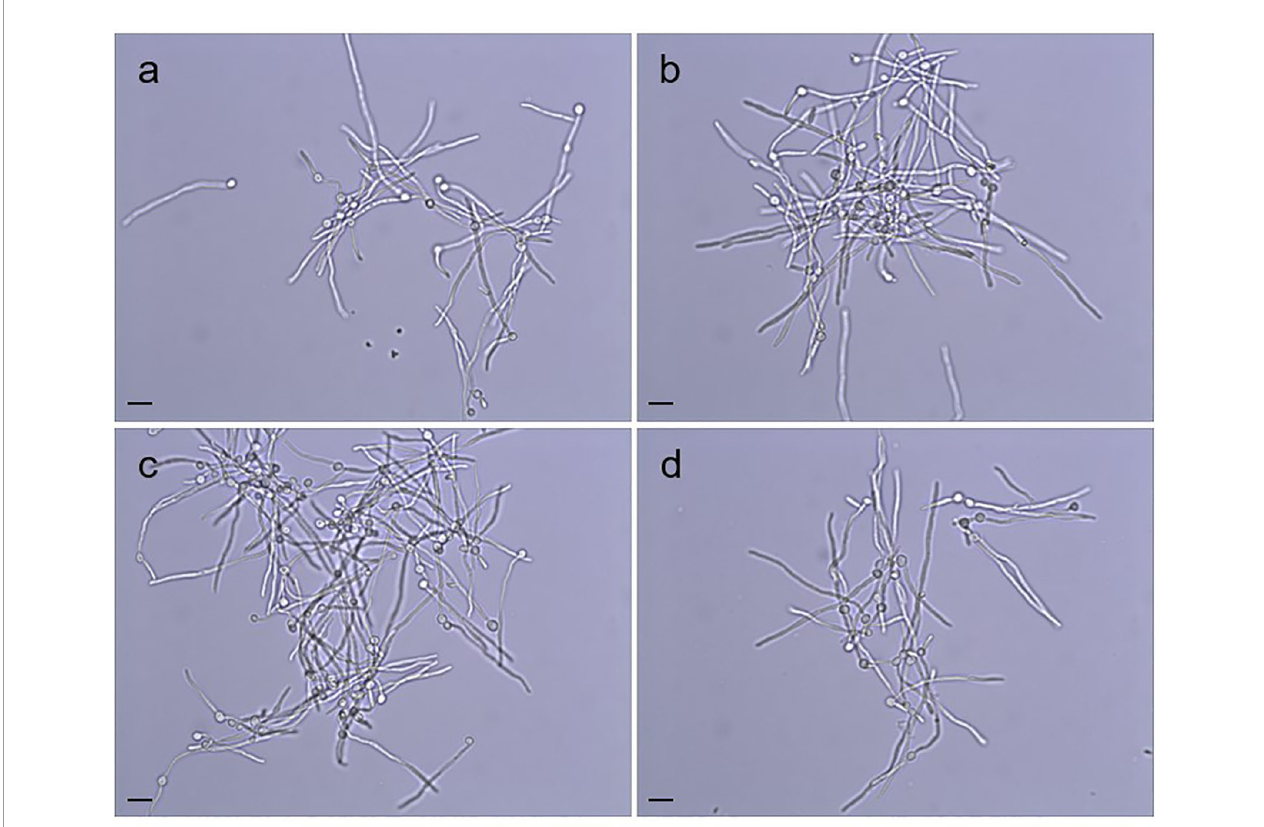
FIGURE 2 | Hypha morphology of the strains (A) SC5314, (B) 3097 ( D pir1-1 / D pir1-2 ), (C) 3545 ( D pir32-1 / D pir32- 2) and (D) 3543 ( D pir1-1 / D pir1-2 D pir32-1 / D pir32-2 ) incubated in FBS. Aliquots were collected from each culture at 2 h, 4 h, 6 h, 8 h and 10 h, while incubating at 28°C or 37°C. Cells shown above were paraformaldehyde- fi xed after incubation at 37°C for 6 h. No difference in the shape, length, or clumping of the hyphae was noted among the strains for any of the growth conditions. The scale bar in the lower left of each image = 10 m